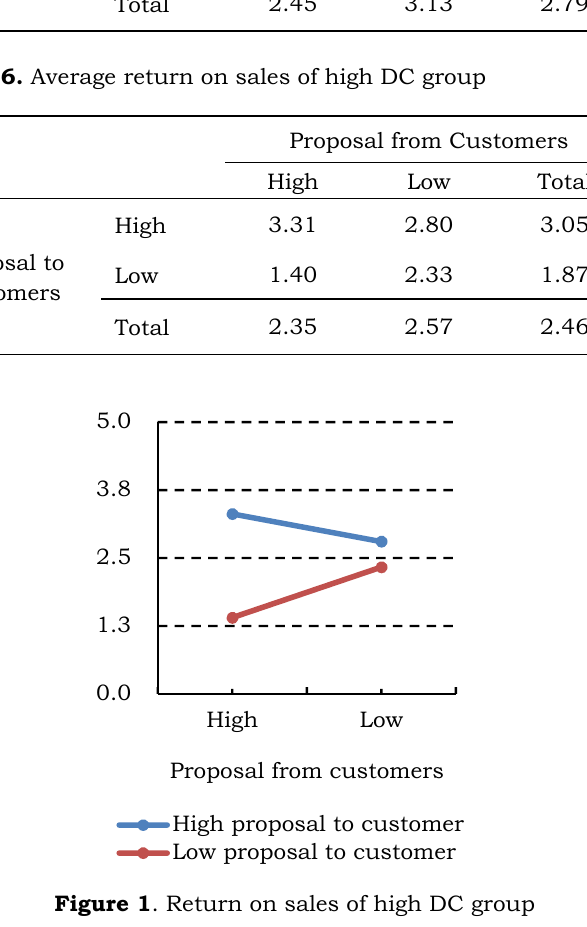
Figure 1 . Return on sales of high DC group